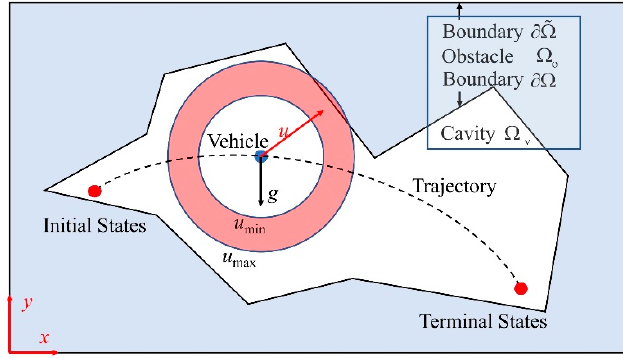
Figure 1. Definition of the coordinate system for trajectory-planning problem.